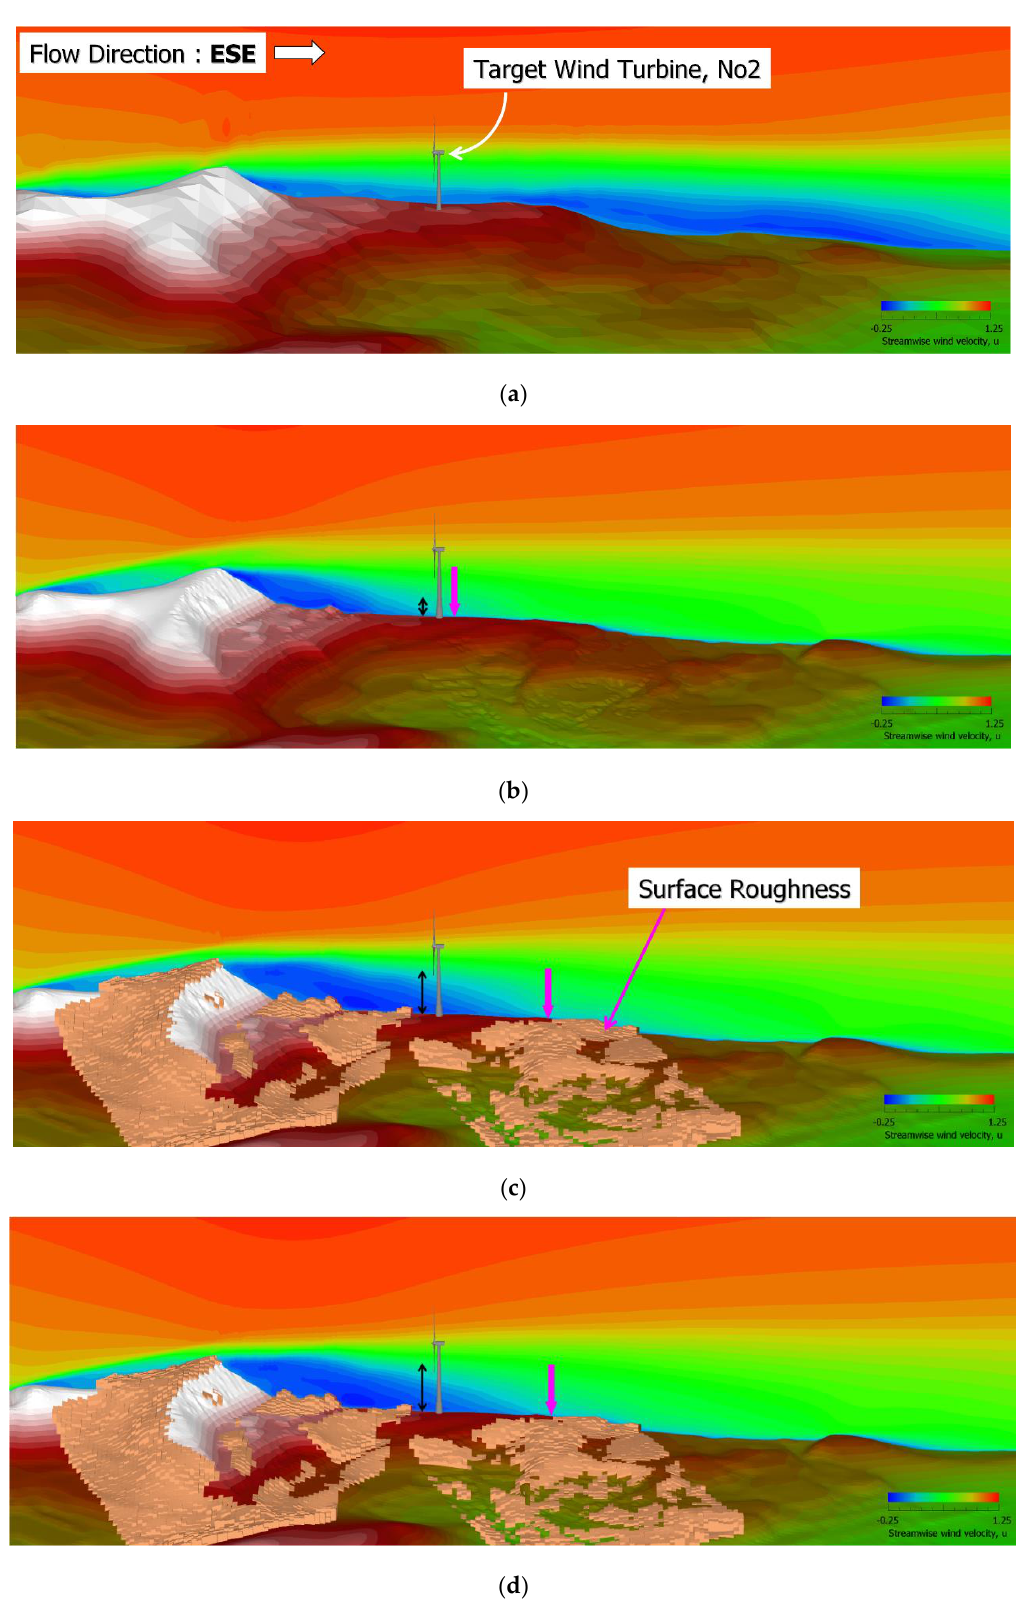
Figure 13. Time-averaged flow field at the wind turbine location for: ( a ) Case1, ( b ) Case2_1, ( c ) Case3, and ( d ) Case4. The effects of the wind turbines were not included in the simulations.